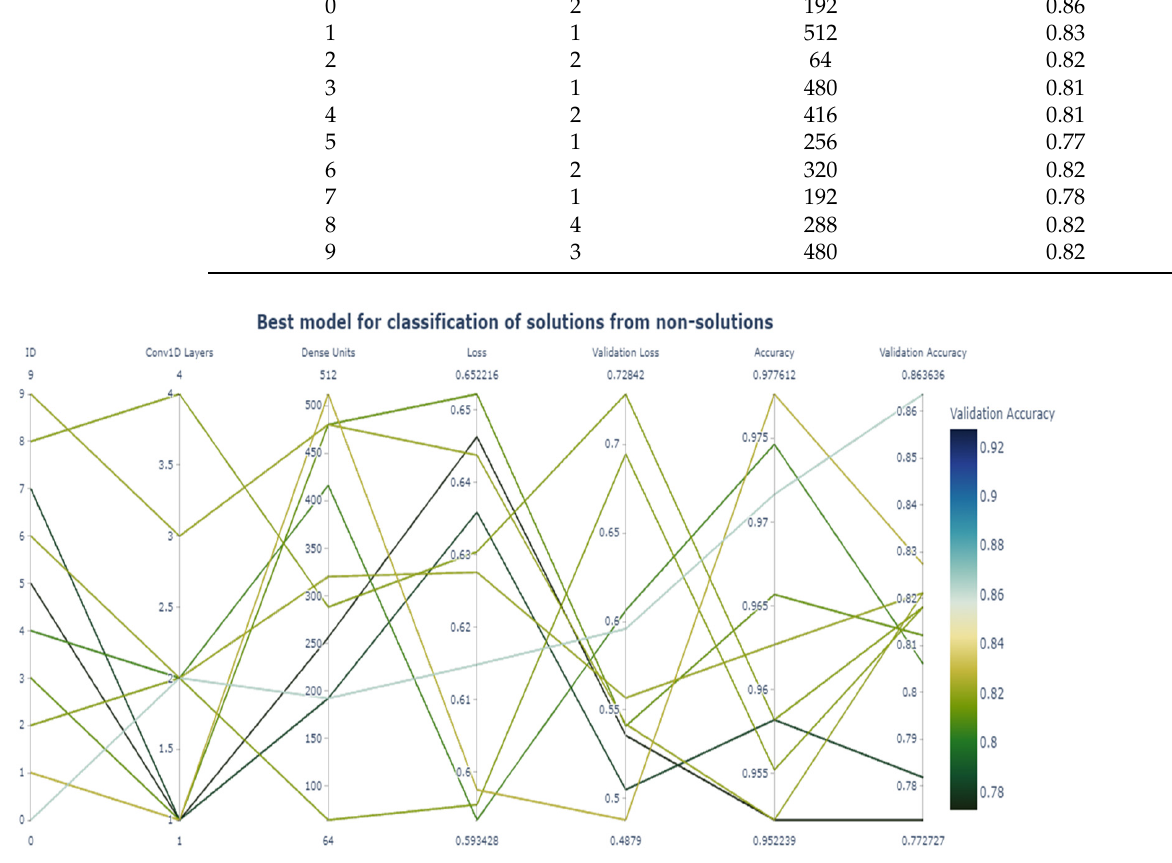
Figure 4. Hyperparameter tuning results for classification of solutions from non-solutions.